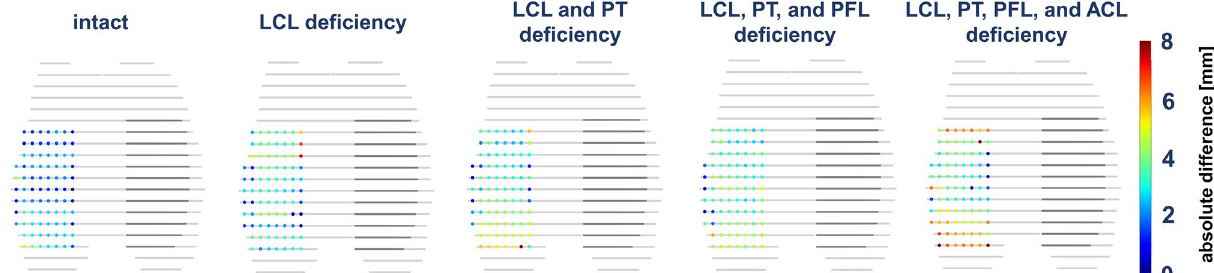
Figure 2. Spatially resolved heat maps of lateral compartmental opening under varus loading as a function of the extent of injury to the posterolateral corner. For each grid point of the lateral compartment, the absolute differences in subchondral cortical distances were quantified between each condition’s unloaded and loaded configurations. Displayed are axial reconstructions of the 3D models and the mean absolute differences across all specimens. Color-coded scale on the right indicates absolute differences (mm). LCL Lateral collateral ligament, PT popliteal tendon, PFL popliteofibular ligament, ACL anterior cruciate ligament.